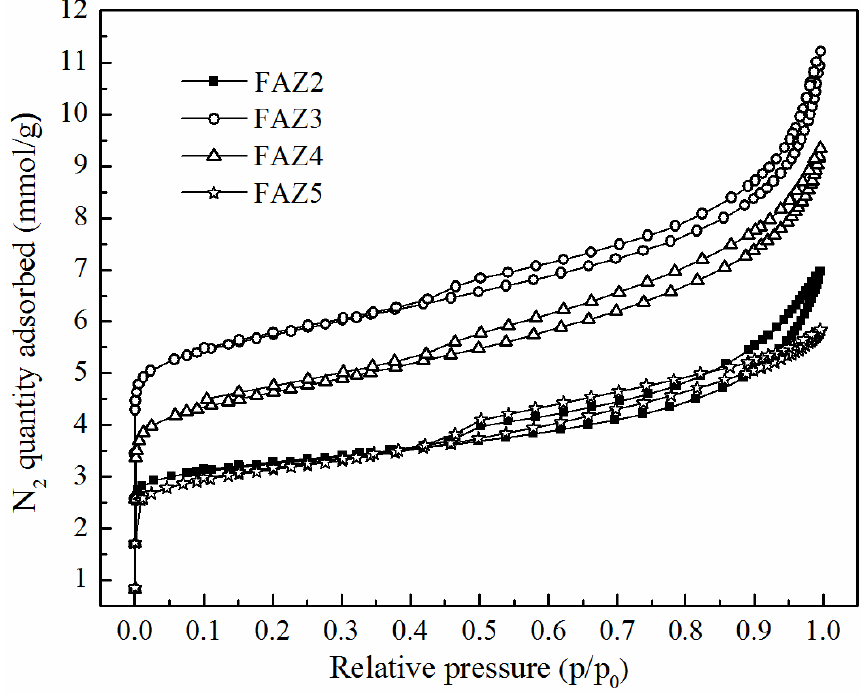
Figure 4. Experimental N 2 adsorption / desorption isotherms of FAZs.